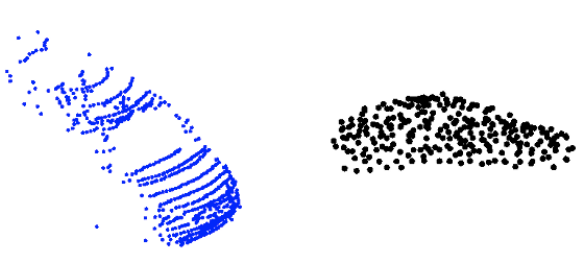
Figure 7. Real vehicle sample (Blue) and variational synthetic sample (Black)